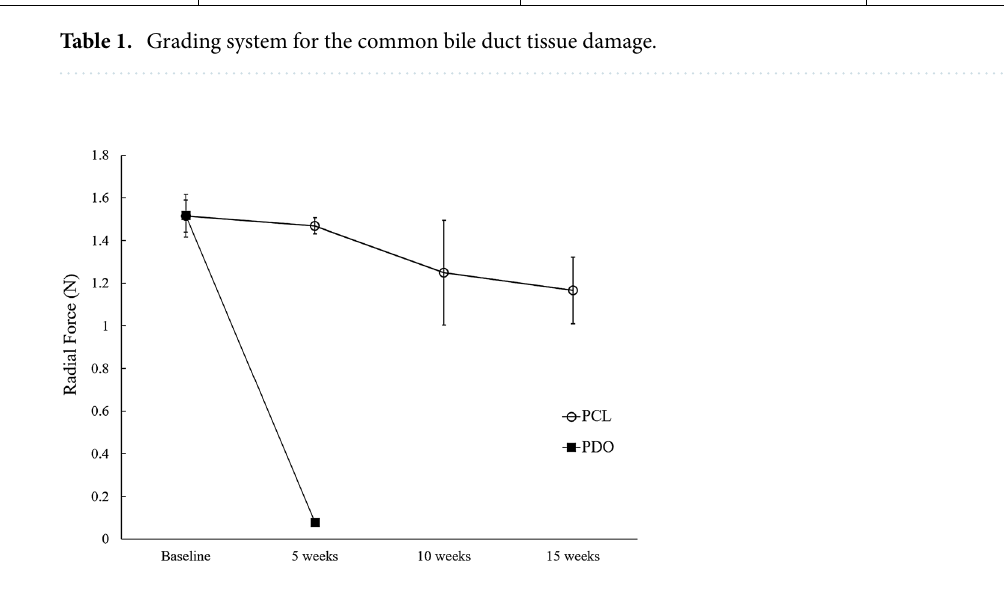
Figure 4. Change of the radial force in polycaprolactone (PCL) vs. polydioxanone (PDO) stents according to the degradation